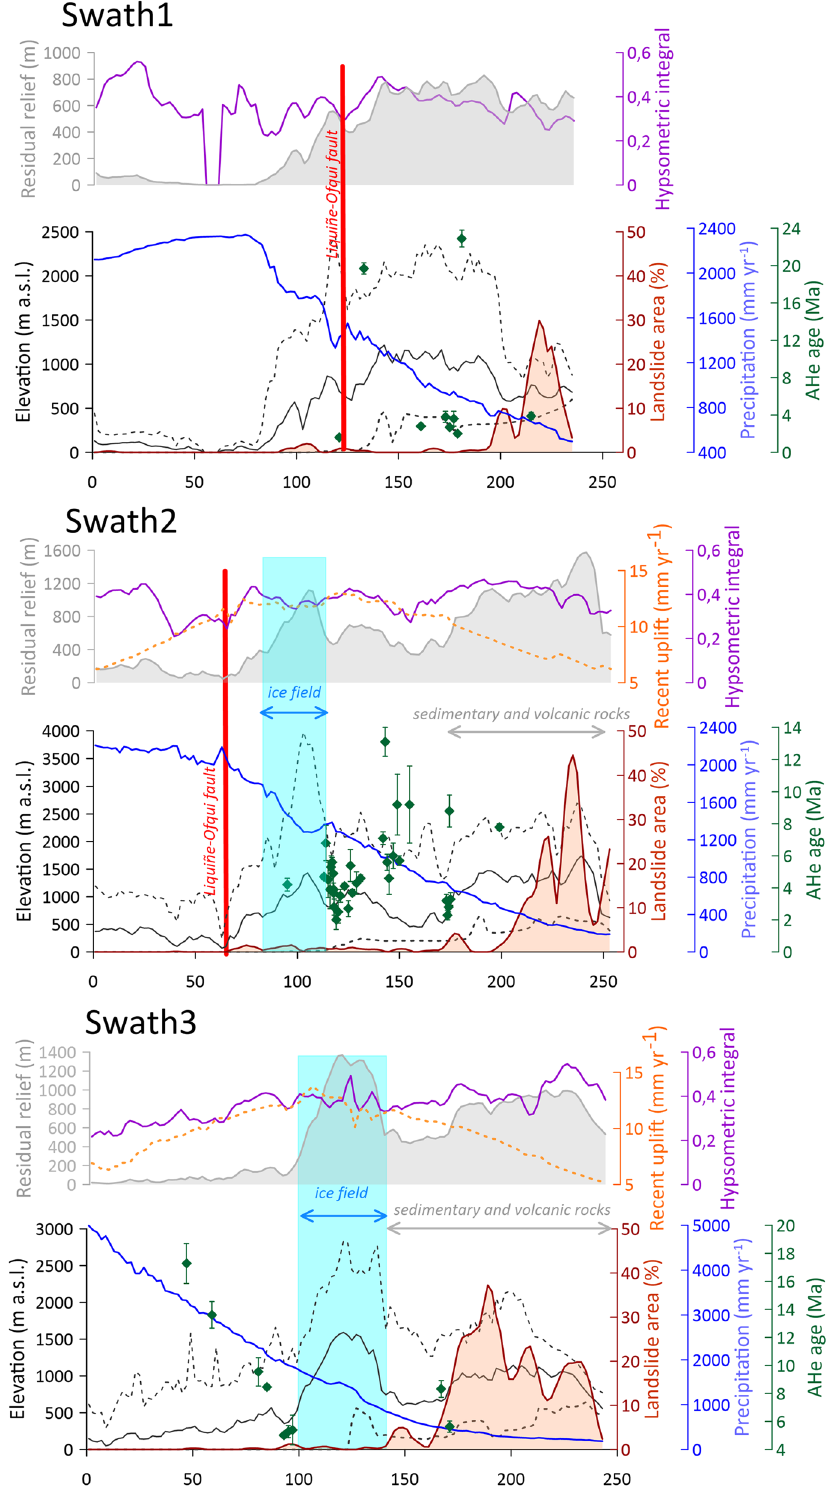
Figure 3. Three 50-km wide swath profiles across the PSI region. Selected landscape variables are plotted against the percentage of area covered by large landslides. Elevation, hypsometric integral and residual relief are calculated from NASADEM, mean annual precipitation totals are from WorldClim.org 46 and recent uplift is according to Richter et al. 36 . AHe ages are from Thompson et al. 43 , Fosdick et al. 27 , Georgieva et al. 40 and Goddard and Fosdick 45 . For locations of swath profiles, see Fig.